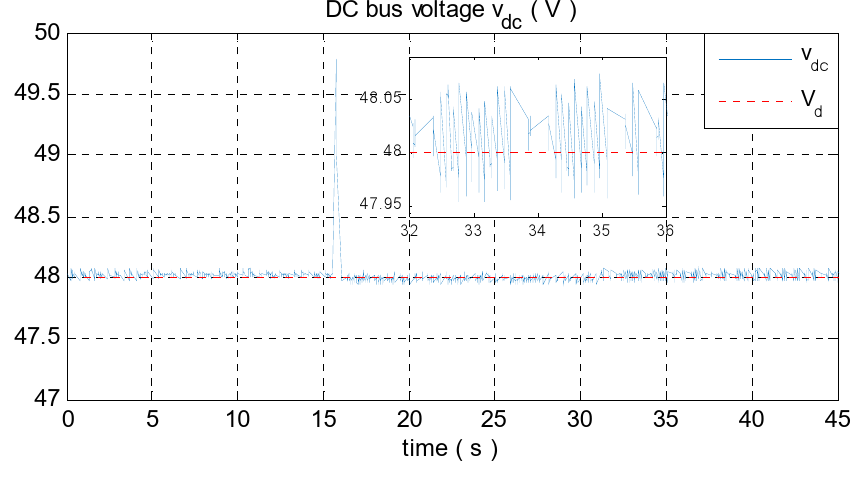
Figure 28. DCbus voltage V dc .